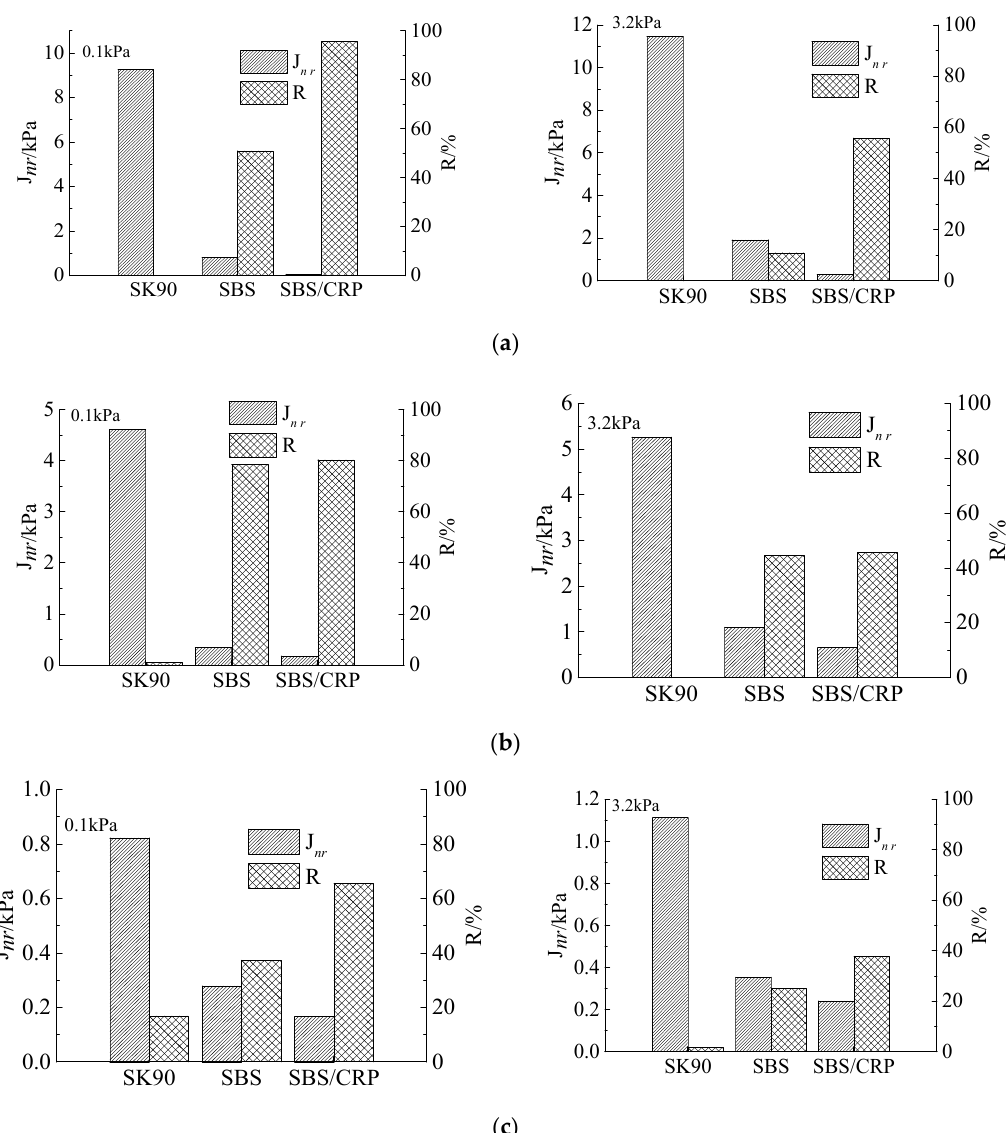
Figure 5. J n r , R at different aging conditions: ( a ) J nr and R of asphalt (unaged); ( b ) J nr and R (TFOT); ( c ) J nr and R (PAV). ( c ) J nr and R